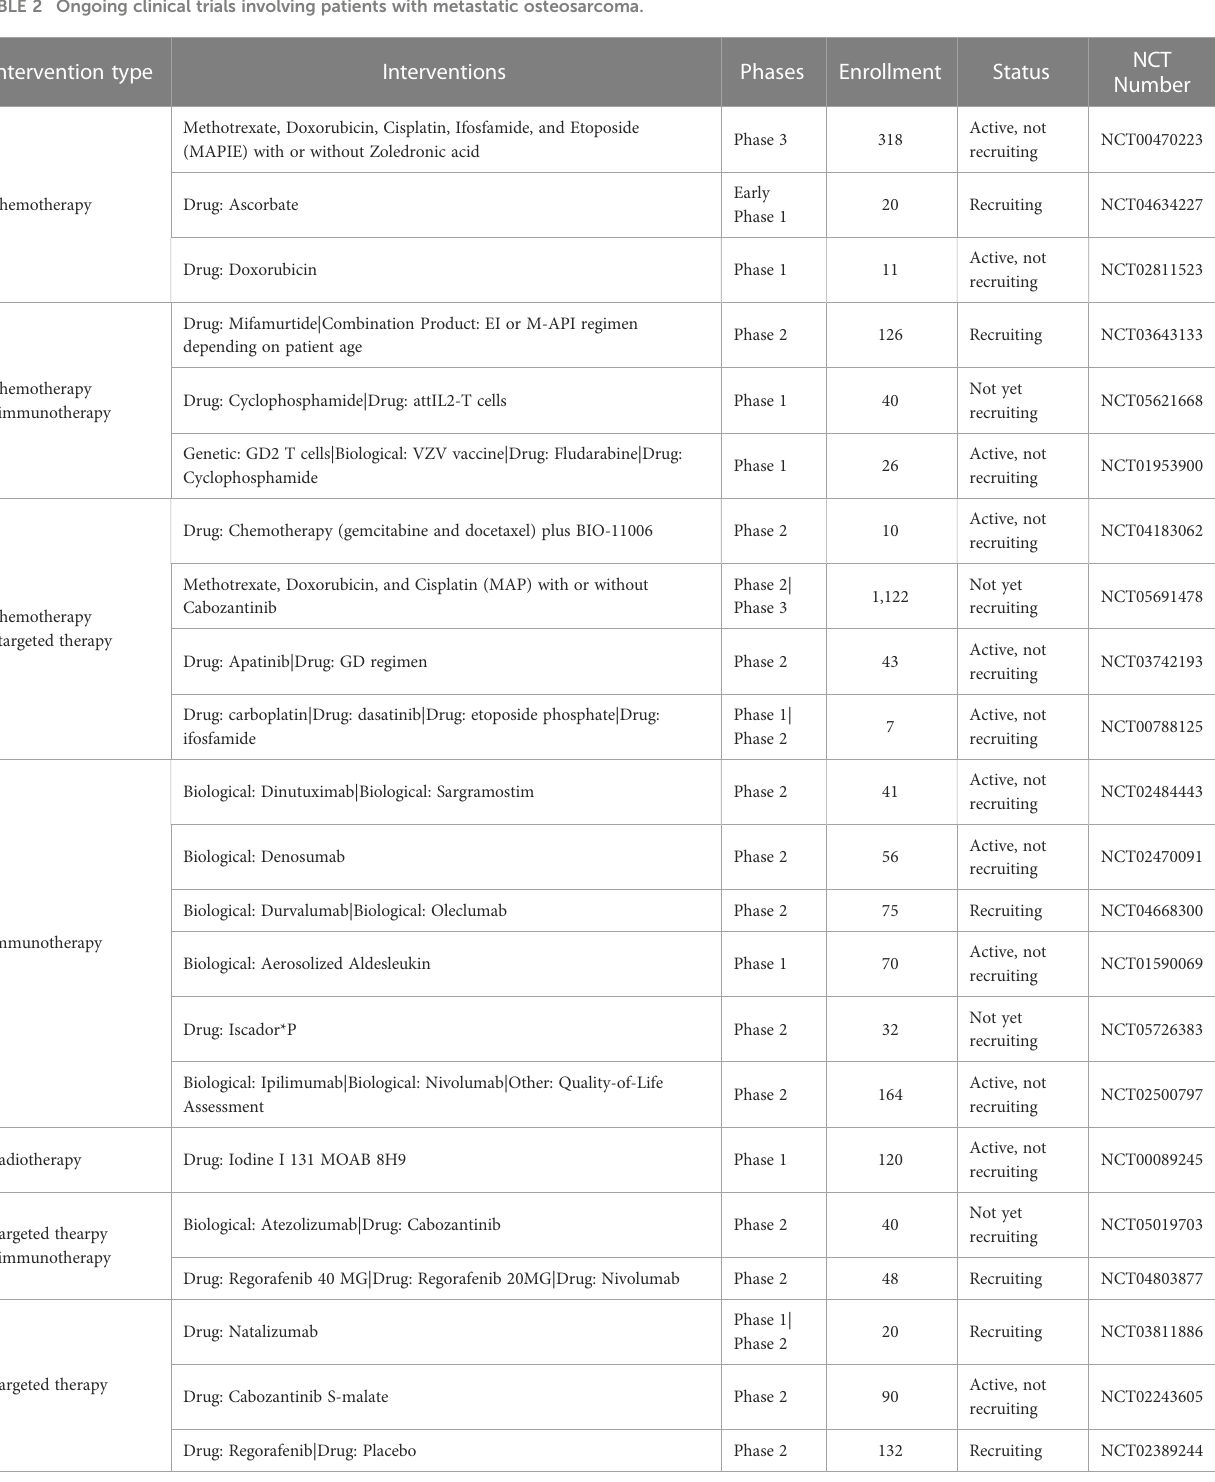
TABLE 2 Ongoing clinical trials involving patients with metastatic osteosarcoma.